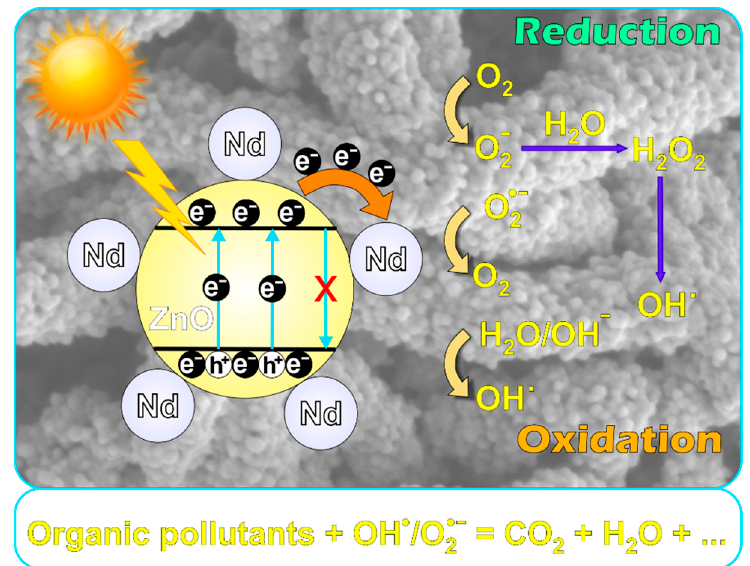
Figure 12. Proposed mechanism of the degradation of organic pollutants in the presence of the Nd- doped ZnO photocatalysts. Nd-doped ZnO